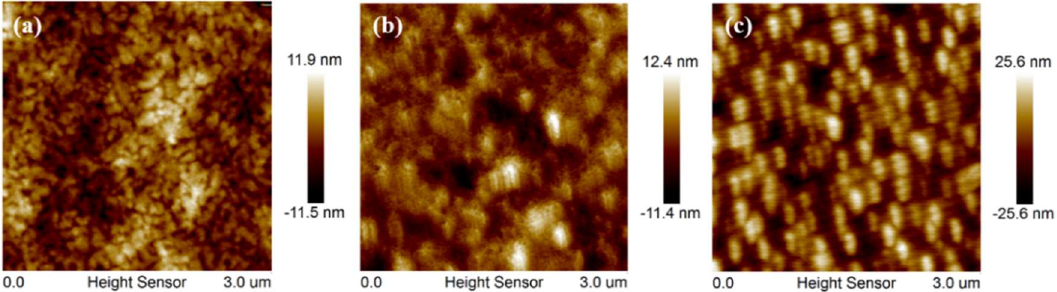
Figure 6. Current density vs. voltage ( a ) hole- and ( b ) electron- devices (inset: current density vs. voltage—built-in voltage (V bi ) curves with fitted lines) based on PB–BtCN, PB–DPQCN, and PB– DBPCN. Figure 7. AFM images of the active layers based on ( a ) PB–BtCN, ( b ) PB–DPQCN, and ( c ) PB–DBPCN.